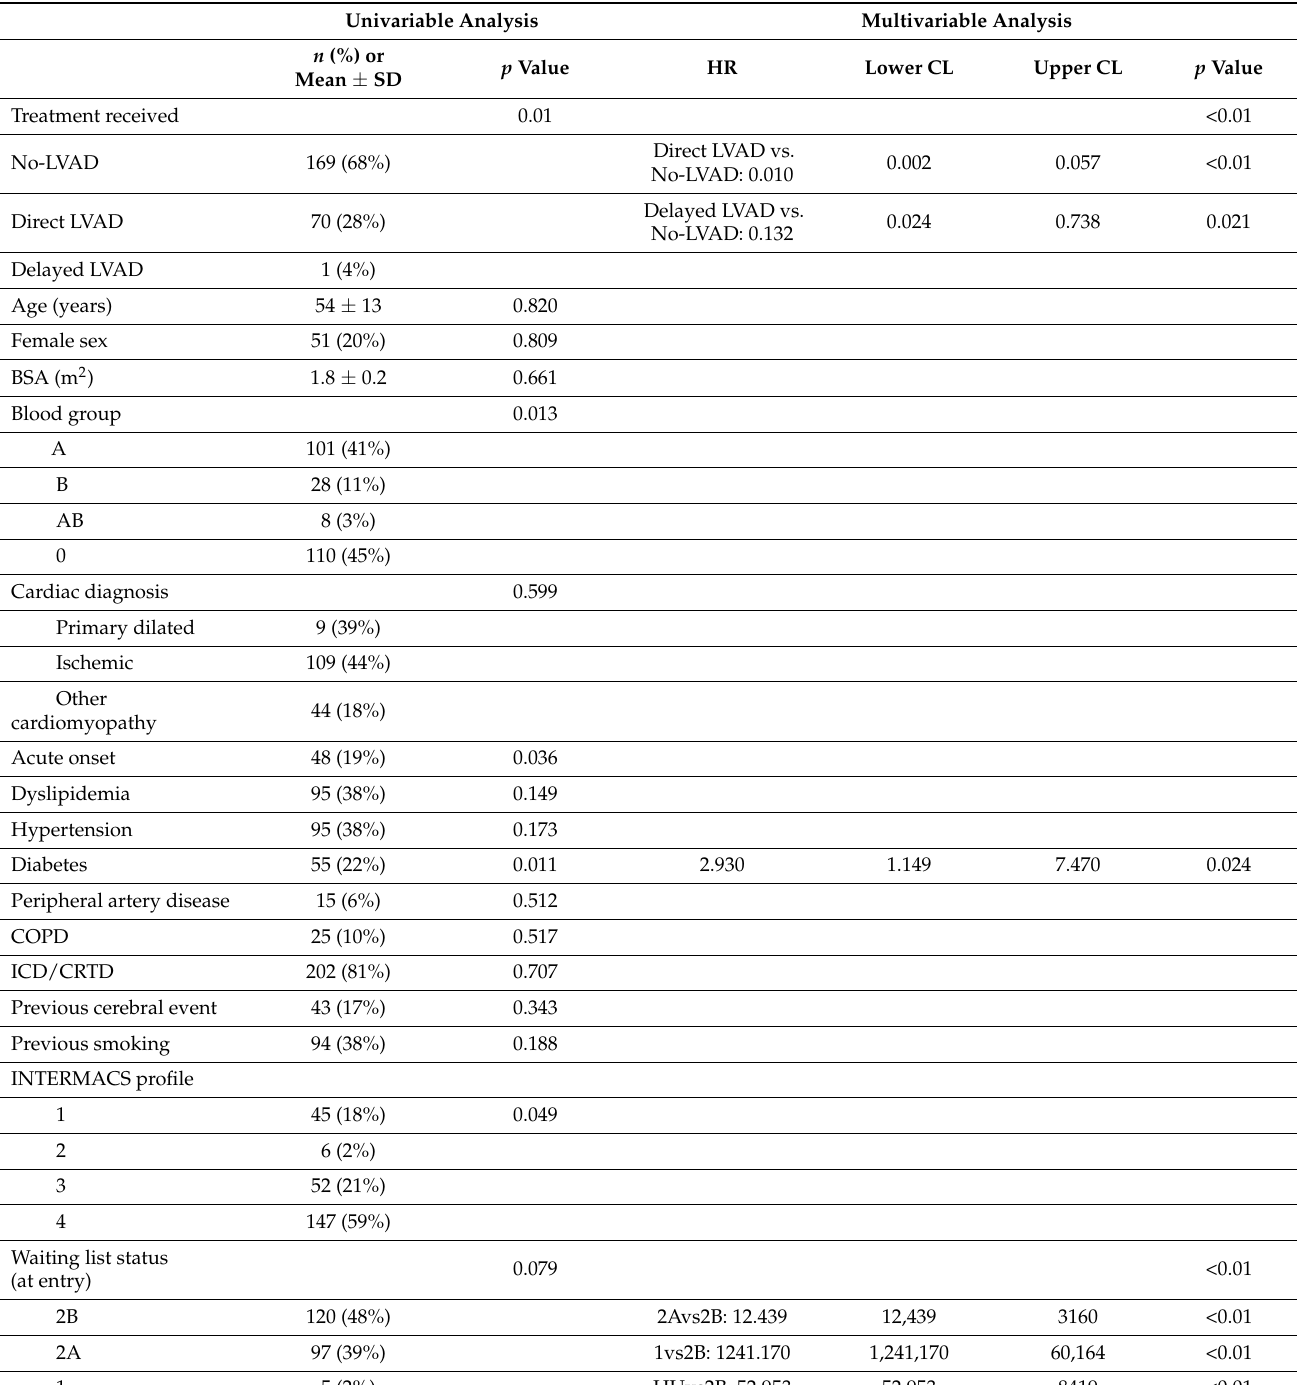
Table 1. Baseline patient’s data and univariable and multivariable analysis of death predictor. Univariable Analysis Multivariable